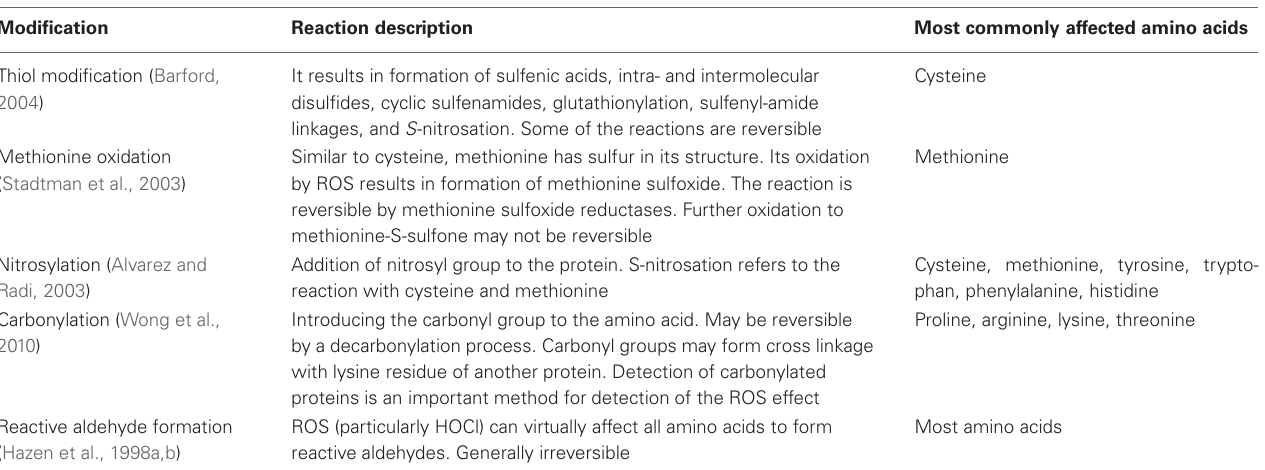
Table 3 | Some important amino acid modifications by reactive oxygen/nitrogen